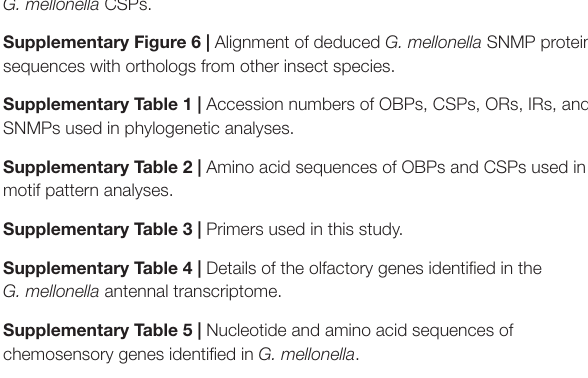
Supplementary Table 6 | Details of the genomic distribution of the G. mellonella olfactory